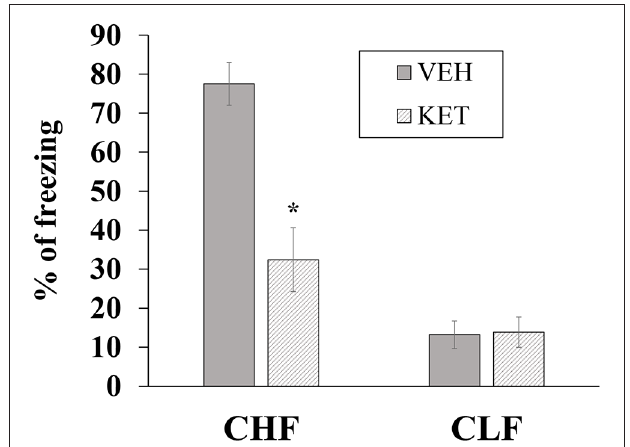
FIGURE 7 | Mean + SEM percentage of time spent freezing in CHF and CLF animals that received ketanserin (KET) or vehicle (VEH) microinjections in the PL cortex. ∗ p < 0.05 KET vs. VEH among CHF